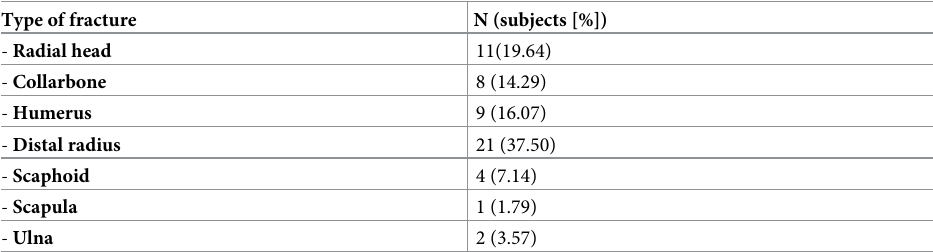
Table 2. Fracture distribution among IULF